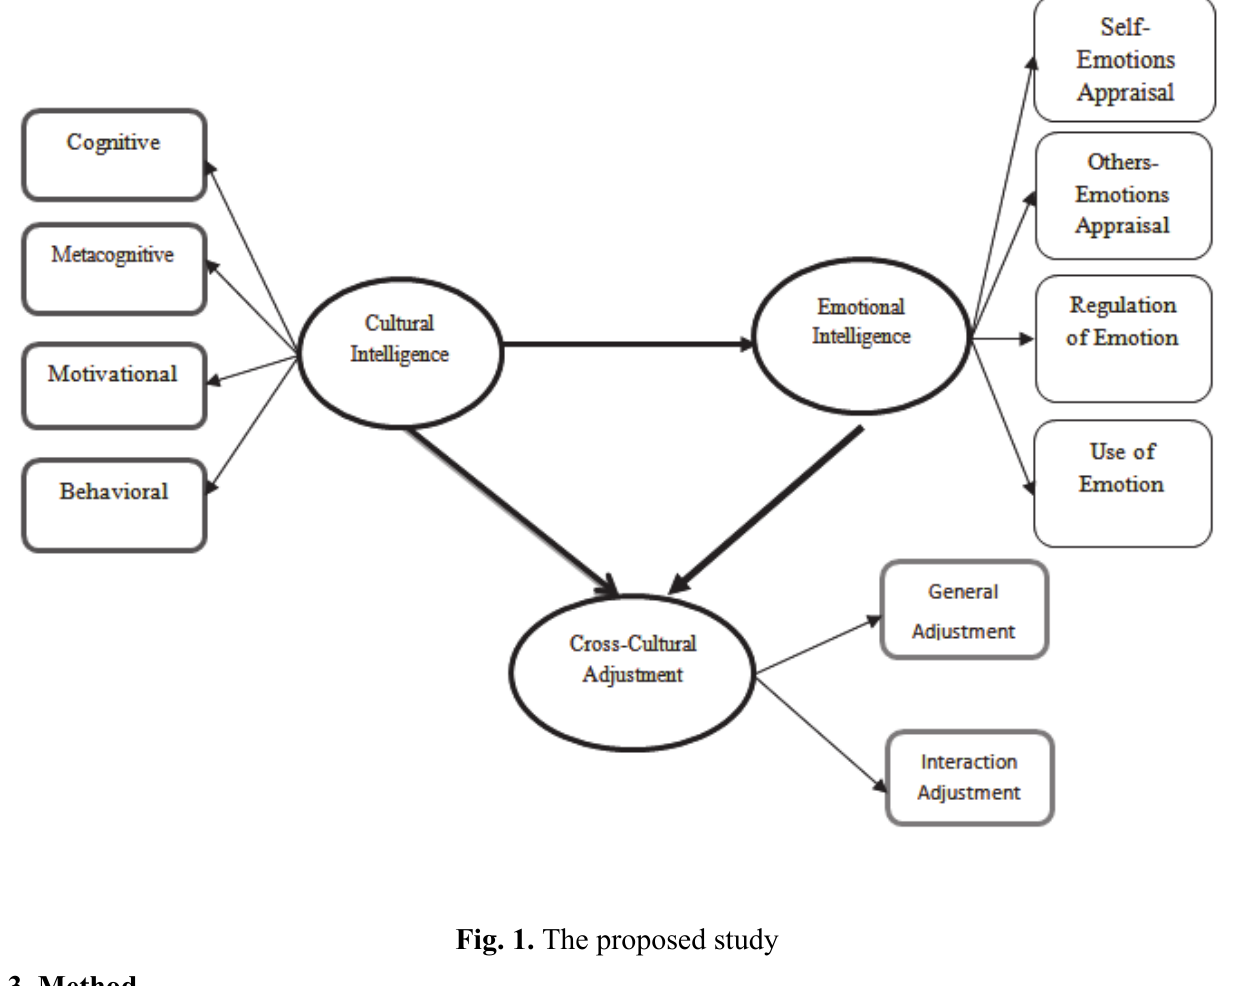
Fig. 1. The proposed